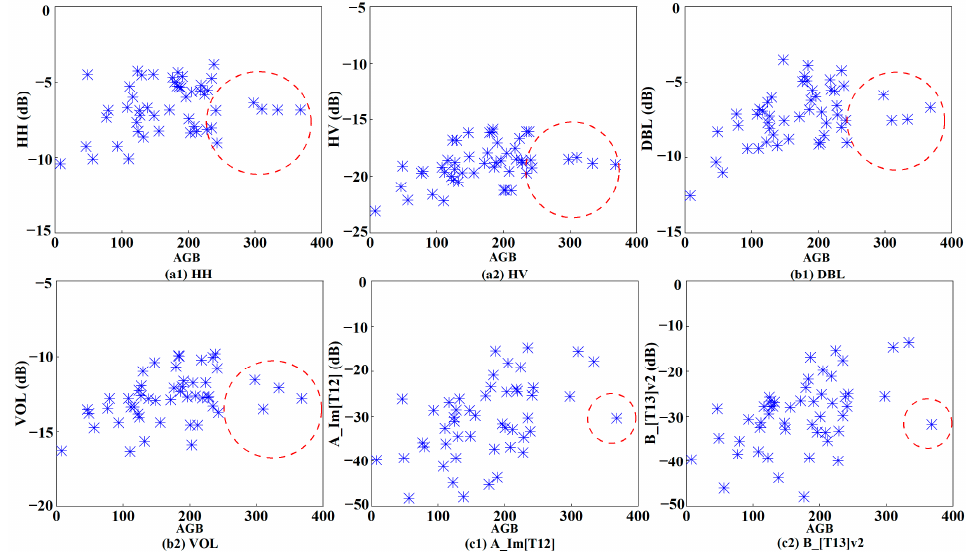
Figure 7. Scatter plot of polarization features and AGB , the part in the red circle is considered sat- urated.